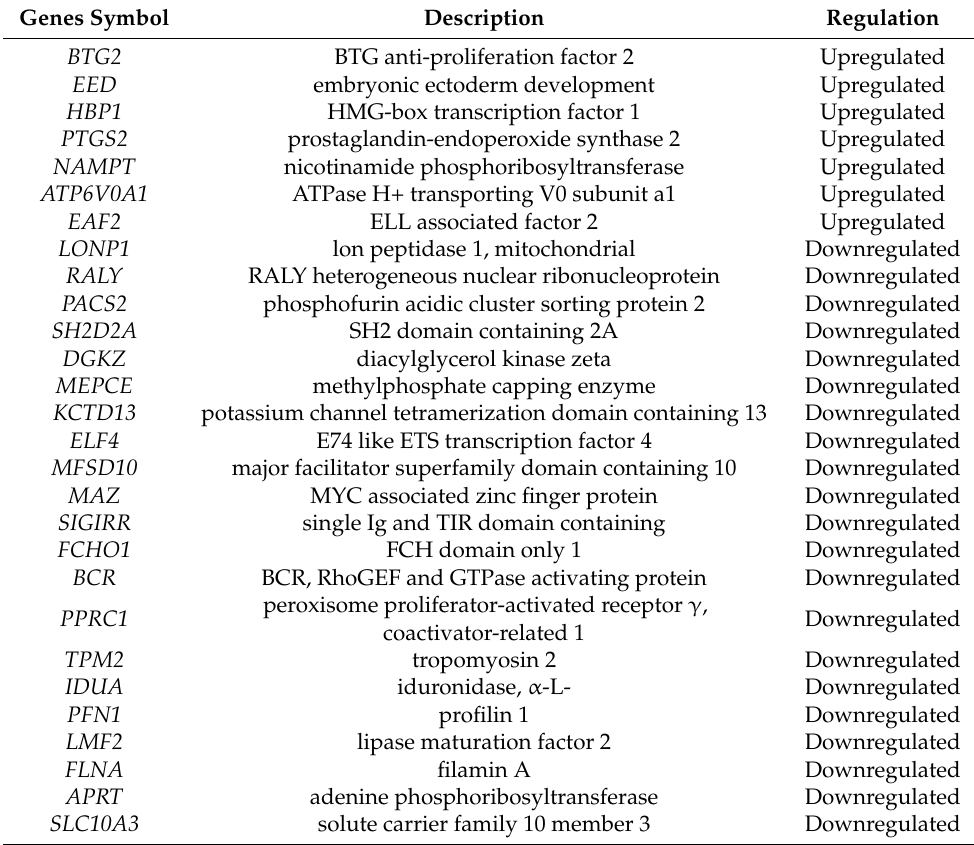
Table 2. Differentially expressed genes concordantly regulated in SCZ and T2DM PBMCs. Genes